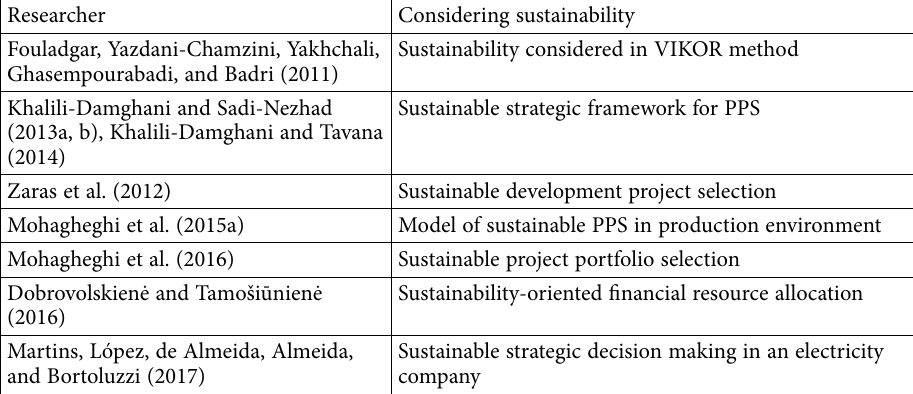
Table 7. A review of papers addressing sustainability in PPS